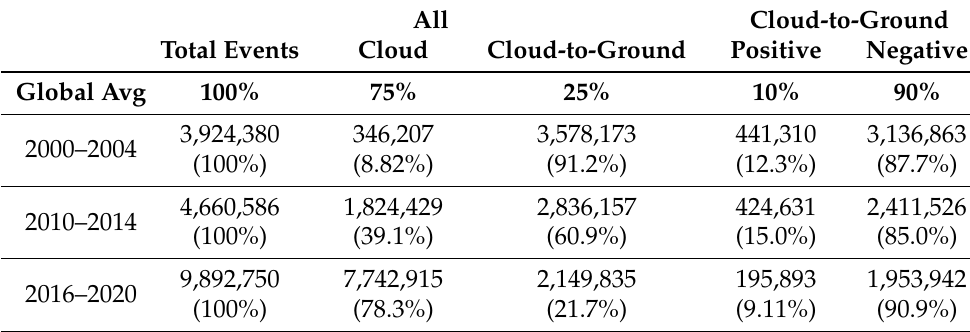
Table 1. Number of Events for the considered dataset